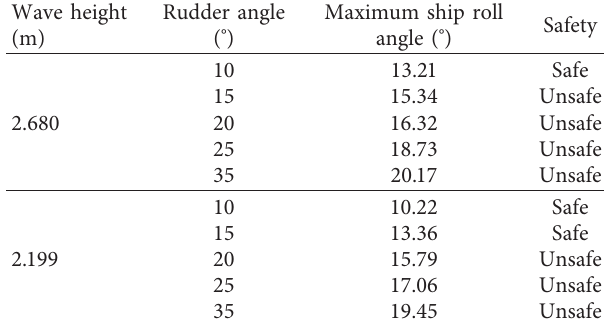
Table 8: Relationship between the steering angle and the maximum roll angle at the initial speed of 32km/h.